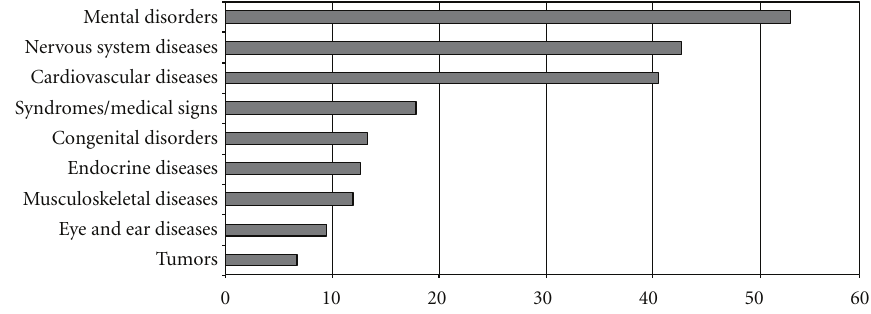
Figure 1: Prevalence of the most common disease group among subjects with severe disability.